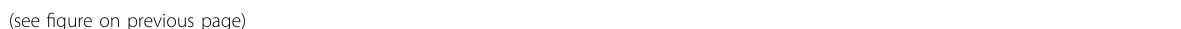
Fig. 1 Hypoxia induces FadA. a The pathway of quantitative proteomic analysis to examine alterations in the protein pro fi le of H37Rv culture fi ltrate using the Wayne model of aeration or hypoxia in vitro. b Volcano map of identi fi ed secreted proteins based on the fold change (Log2) and t test P - value ( − Log10) by comparing hypoxia with aeration. c qPCR analysis of Rv0859 ( fadA ) mRNA from H37Rv incubated under aeration and hypoxia for 0, 7, or 14 days in vitro (mean ± SEM). Data are representative of one experiment with at least three independent biological replicates; each circle represents one technical repeat. Bar charts show means. d Immunoblot (IB) of culture fi ltrate and cell lysate from H37Rv incubated under aeration and hypoxia for 0, 3, 7, or 14 days with anti-FadA, anti-ESAT-6, or anti-SigA antibodies at a 1:1000 dilution. Bars represent densitometric analysis of band intensity. e Immunolocalization of FadA in lung granuloma sections from TB patients and whole fi sh sections of M. marinum infected adult zebra fi sh with anti-FadA polyclonal antibody at a 1:100 dilution and anti-rabbit secondary antibody labeled with HRP at a 1:200 dilution (scale bar, 100 μ m (top) and 20 μ m (bottom)), compared with anti-ESAT-6 polyclonal antibody at a 1:200 dilution, isotype polyclonal control antibody at a 1:100 dilution, anti-SigA antibody labeled with HRP at 1:100 dilution and acid-fast staining (scale bar, 100 μ m (top) and 20 μ m (bottom)). The red triangle indicates multinucleated giant cells. Results of d , e are representative of three independent experiments. Two-tailed unpaired Student ’ s t test ( c ) was used for statistical